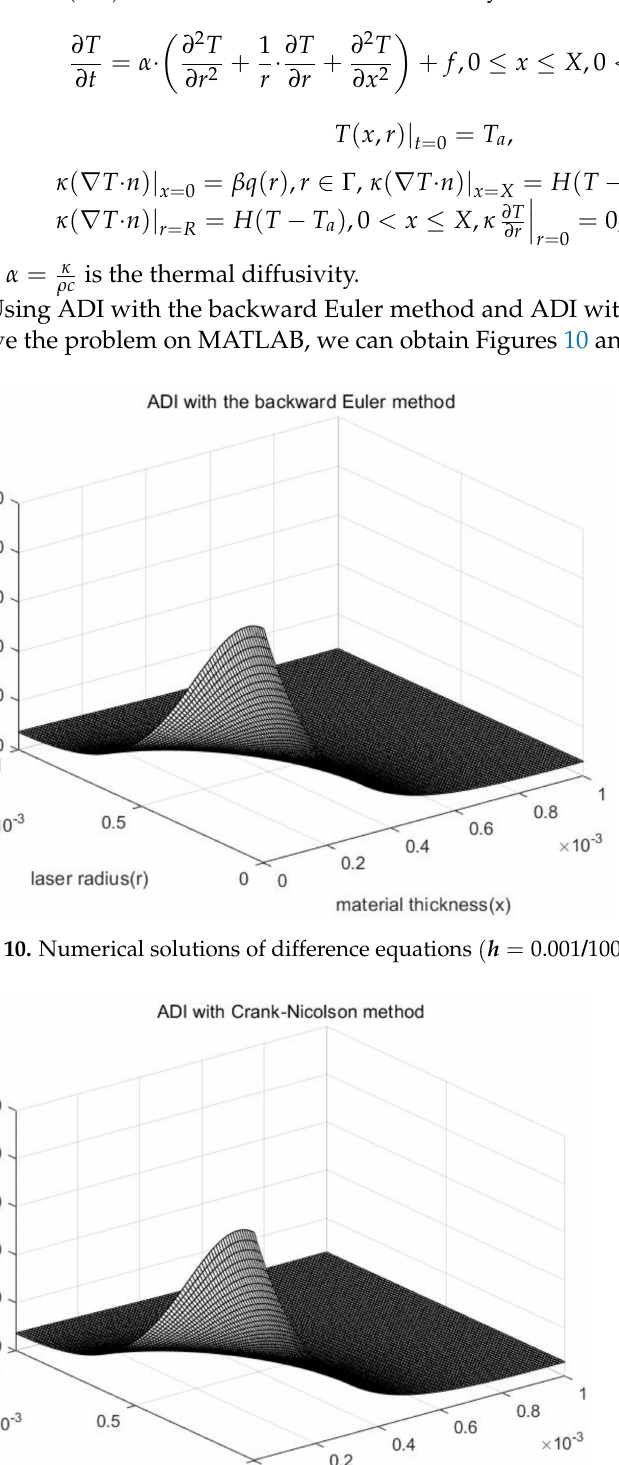
backward Euler method when h = 0.001/100, τ = 0.01/1000 and H =